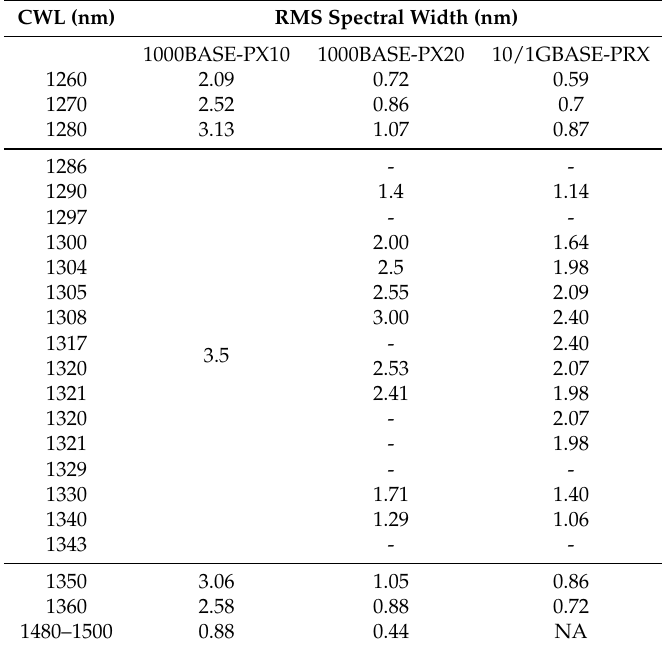
Table 4. IEEE laser requirements for PONs [12,13].